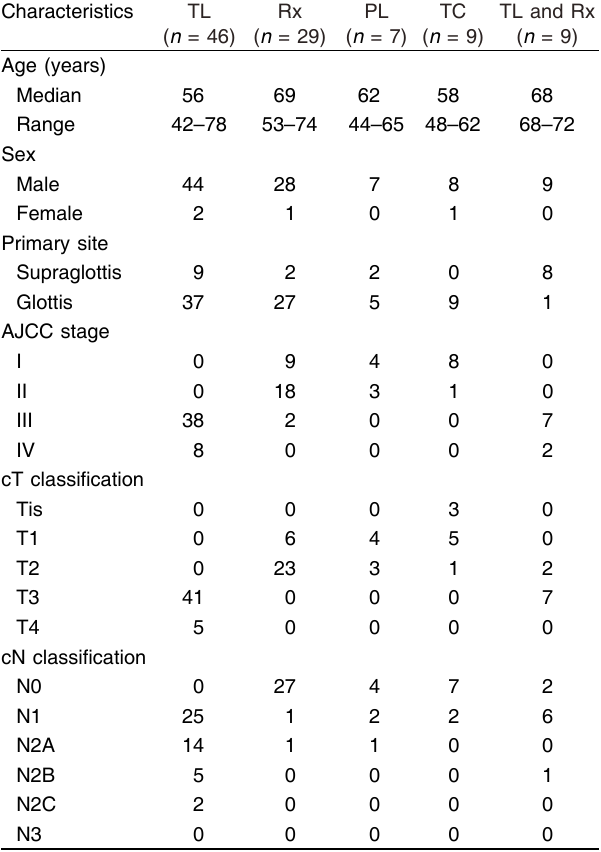
Table 2 Characteristics of the patients according to the primary treatment group (TL, Rx, PL, TC, TL and